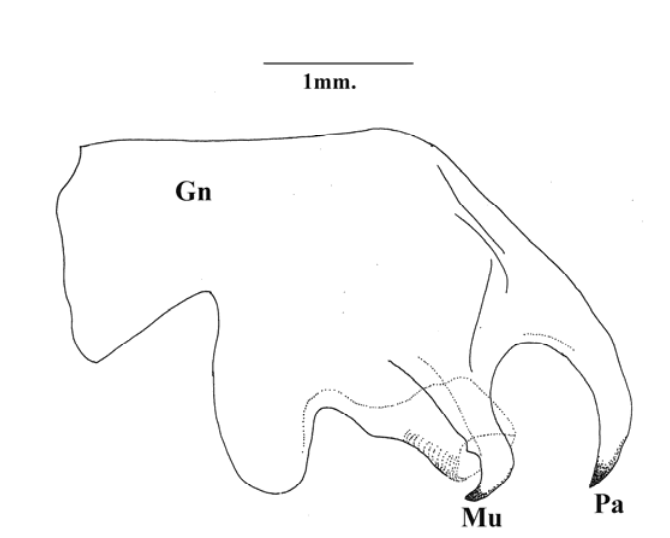
FIG . 7.- Male genitalia of Cueta luteola .Gn; gonarcus,Pa: paramer ,Mu;